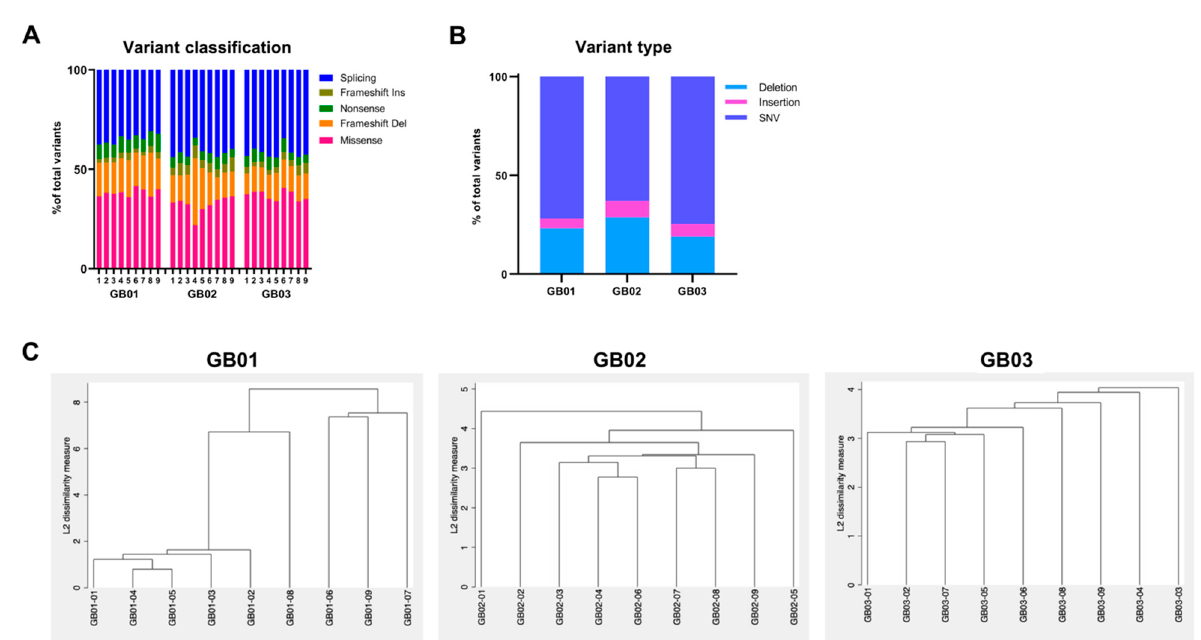
Figure 4. Rare variants. ( A ) Proportion of variant classification, plotted as the percentage of the total number of detected rare variants. ( B ) Proportion of mutation type, plotted as the percentage of the total number of detected rare variants. ( C ) Dendrograms of hierarchical cluster analysis of rare mutations of tumor regions. Dendrograms graphically present the information concerning which tumor regions are grouped together at various levels of (dis)similarity. At the bottom of the dendrogram, each tumor region is considered its own cluster. The height of the vertical lines and the range of the (dis)similarity axis give visual clues about the strength of the clustering. Long vertical lines indicate more distinct separation between the groups. Long vertical lines at the top of the dendrogram indicate that the groups represented by those lines are well separated from one another. Shorter lines indicate groups that are not as